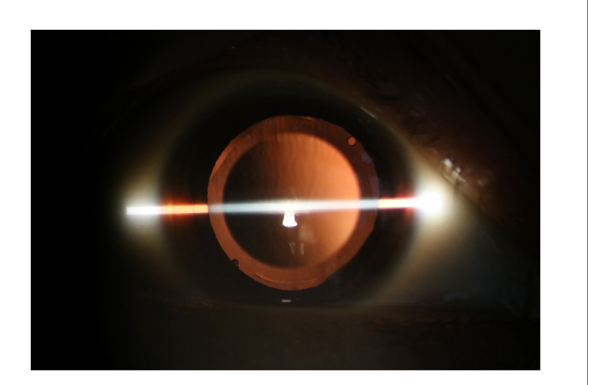
FIGURE 6 The implantable collamer lens position has remained well in situ for 3 years following rotation to the oblique position in patient